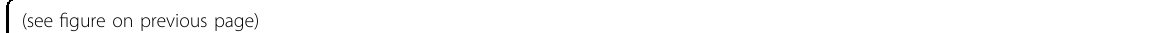
Fig. 1 Establishment of reprogrammed H460 (R-H460) cells. a H460 cells were reprogrammed using the Stemgent mRNA Reprogramming System (Reprocell, Beltsville, MD, USA). Schedule for establishing R-H460 cells by transfecting the mRNAs of reprogramming factors. Reprogramming factors were transfected daily from day 1 (D1) to day 22 (D22). After the initial use of reprogramming medium (R-medium), conditioned R-medium was used from day 9 (D9) onward, and the B18R recombinant protein was added to the medium from day 24 (D24) onward. Depending on the schedule, feeder layers, CELLstart TM CTS TM (CTS; Gibco Thermo Fisher Scienti fi c)-coated plates, or Matrigel-coated plates were used. The fi nal R-cancer cell clones were picked approximately 30 days after the initiation of transfection and maintained in stem cell medium (mTeSR TM 1; STEMCELL technologies). b TRA-1-60 staining for the establishment of R-H460 cells. Bright- fi eld images of H460 cells on day 1 (D1) and day 22 (D22) after the initiation of transfection are shown, along with the TRA-1-60 status at D22 (TRA-1-60 at D22). TRA-1-60 positivity in the established R-H460 cells (R- H460) was tested again after the subculture of the R-H460 colonies (TRA-1-60 in R-H460). c Alkaline phosphatase staining was positive in transfected H460 cells at D22 but not in parental H460 cells. The inset shows a magni fi ed image. d Scheme for the preparation of differentiated R-H460 cells (dR- H460). R-H460 cells were differentiated by the withdrawal of stem cell medium for the indicated periods of time and were referred to as dR-H460 cells (for example, if R-H460 cells were differentiated for 3 days, they were referred to as 3dR-H460 cells). e – h Colony-formation assay after drug treatment. dR-H460 cells were treated with cisplatin (5 μ M) or paclitaxel (5 nM) for 3 days. After culture in drug-free media for approximately 30 days, the drug- resistant colonies were counted. e , g The median colony numbers and the P -values relative to H460 are indicated. Experiments with cisplatin and paclitaxel were repeated 3 and 2 times, respectively. f , h Representative images of the colony-formation assay. i Loss of alkaline phosphatase activity along with differentiation. Alkaline phosphatase was positive in some of the R-H460 cells until day 3 after the withdrawal of stem cell medium but faded out to become negative on day